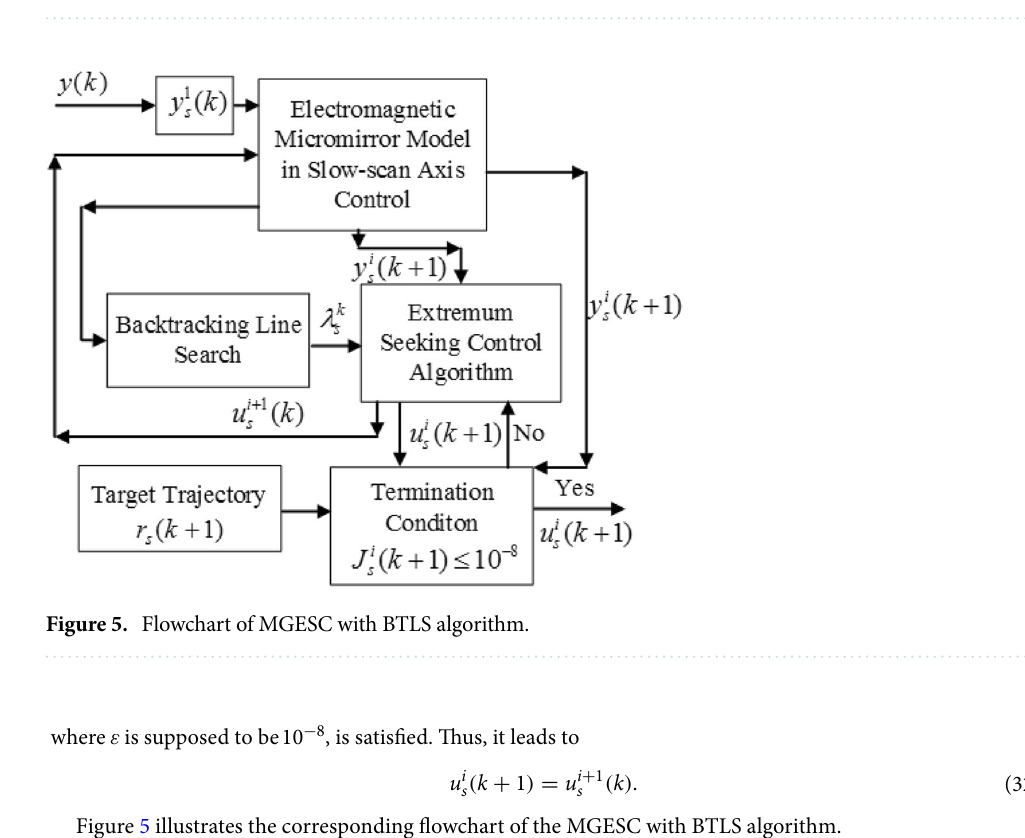
Figure 4. Flowchart of backtracking line search.